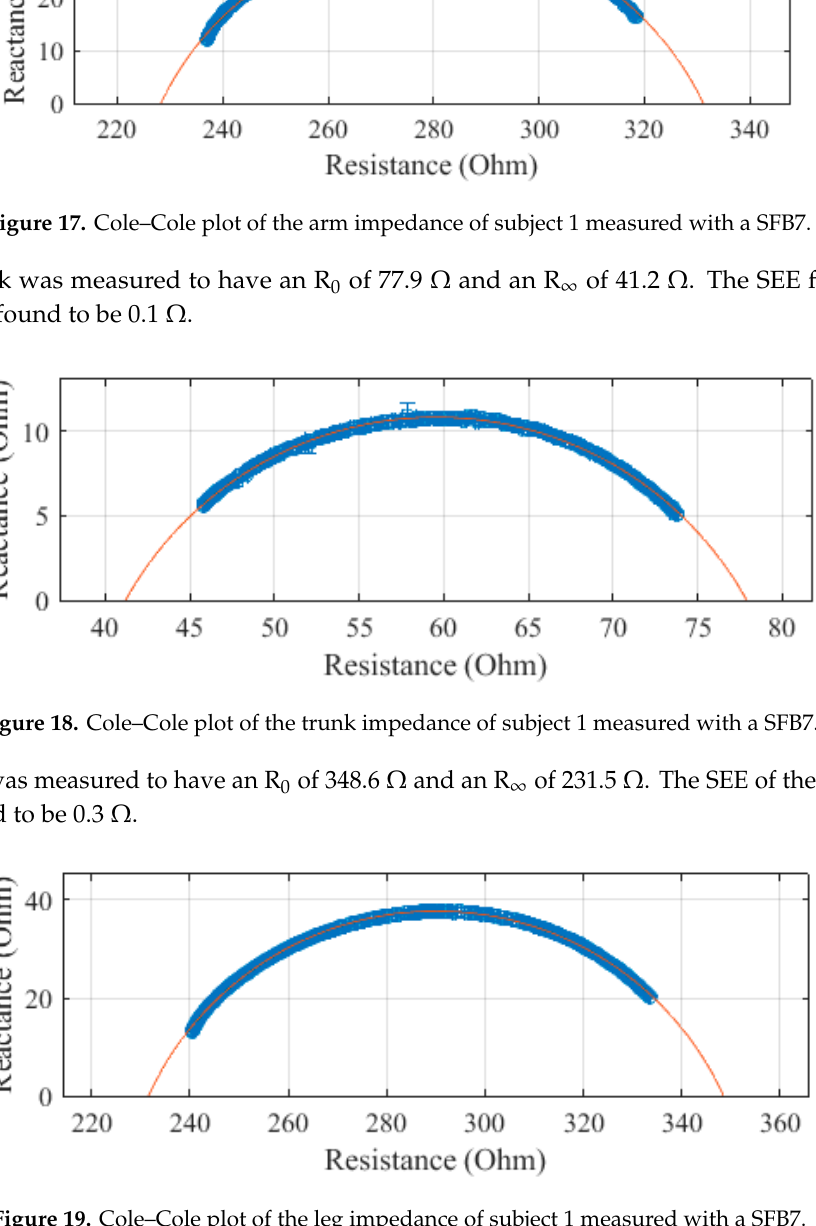
Figure 19. Cole–Cole plot of the leg impedance of subject 1 measured with a SFB7. A comparison of the R 0 and R ∞ values determined with the three devices is presented in Table 1. Table 1. Device comparison for subject 1.